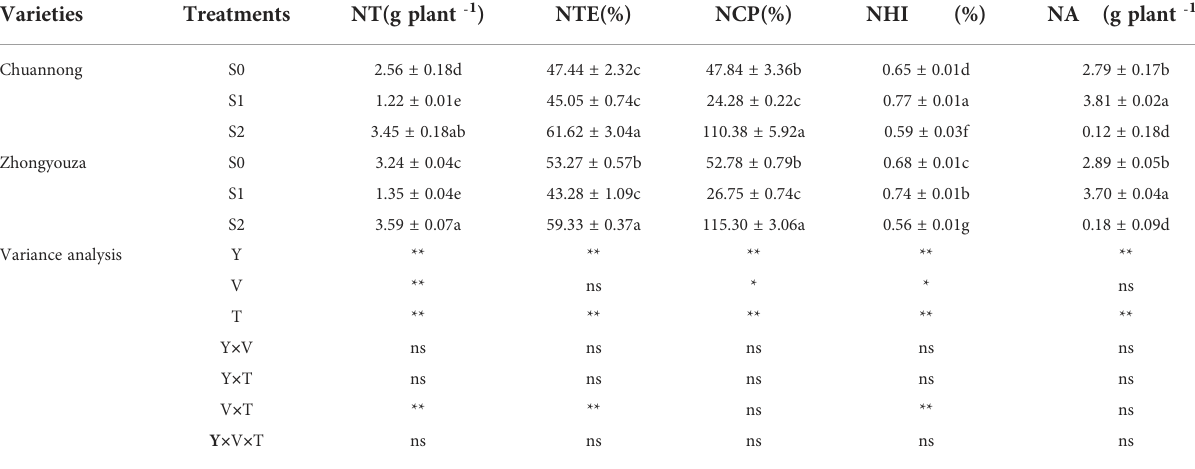
TABLE 2 Effect of shading on nitrogen translocation (NT), nitrogen translocation ef fi ciency (NTE), nitrogen contribution proportion (NCP), nitrogen harvest index (NHI) and nitrogen assimilation (NA) in rapeseed. Varieties